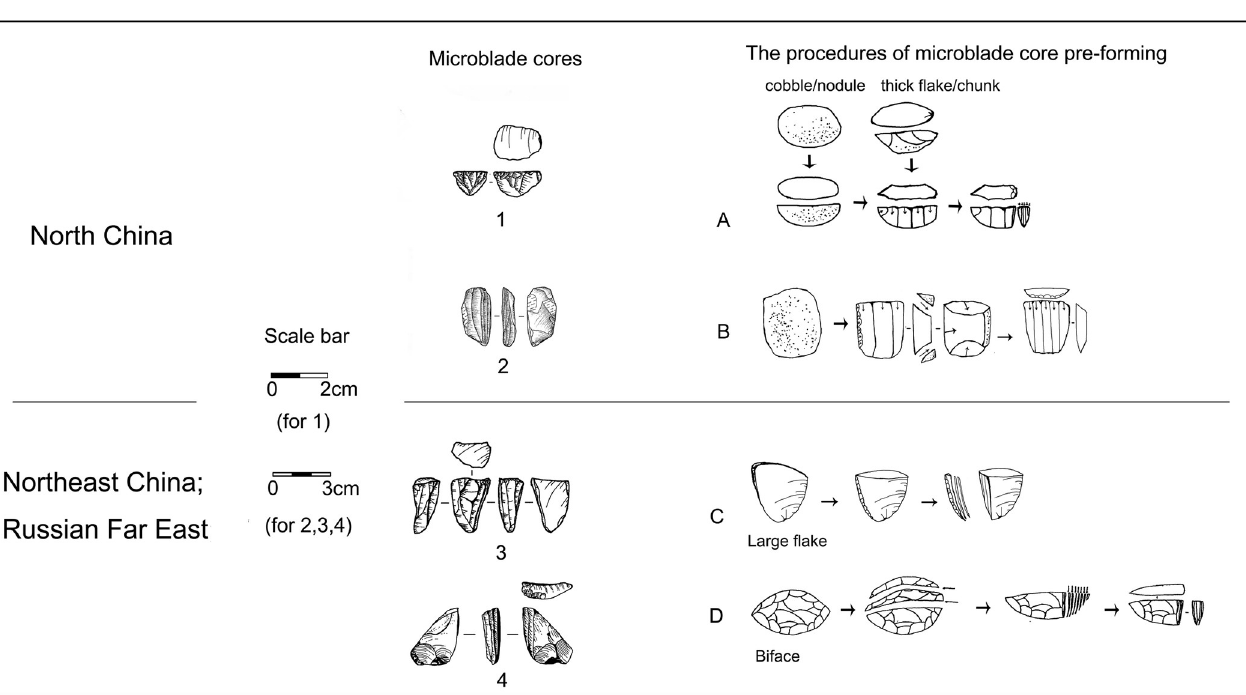
Fig 7. A comparison of the microblade core pre-forming methods between North China and Northeast Asia (include Northeast China, Russian Far East, and Korean Peninsula (1: Boat-shaped core from Longwangchan; 2: Semi-conical core from Shizitan; 3: Wedge-like core from Xishantou; 4: Wedge-like core with Yubetsu method from Ust-Ulma; 1: After [112]; 2: After [108]; 3: After [111]; 4: After